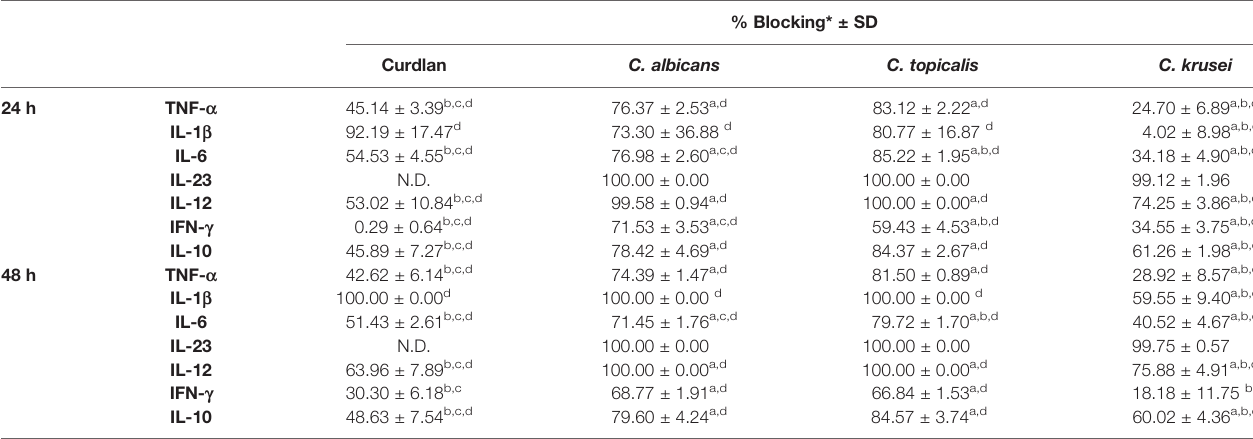
TABLE 2 | Blockade of dendritic cell (DC) cytokine production by dectin-1